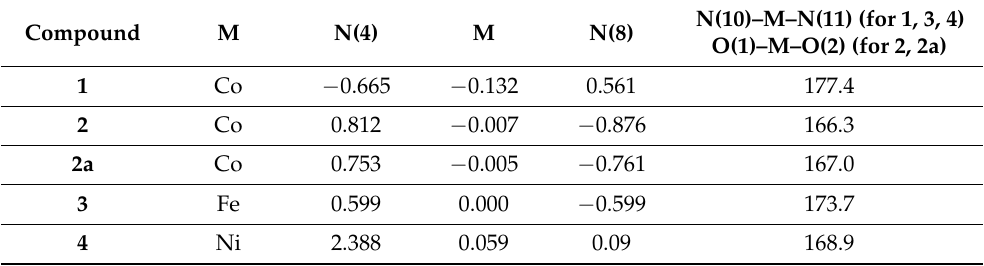
Table 3. Deviation of the donor atoms and the metal center M from the equatorial plane (least-squares plane of atoms M, N(1), N(2), N(6)), and value of the N(10)–M–N(11) angle. Compound